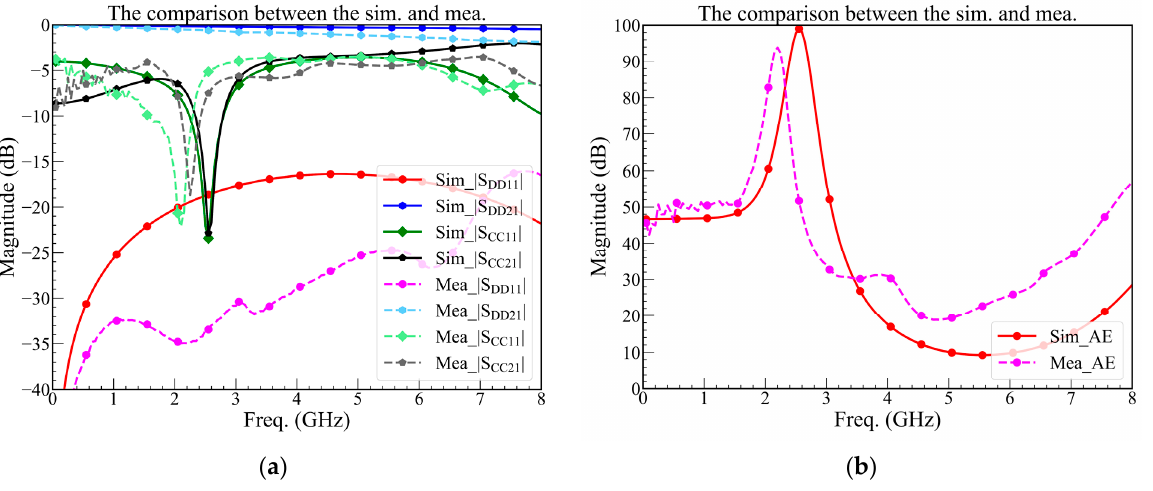
Figure 11. ( a ) The comparison of mixed-mode S -parameter of simulation and measurement; ( b ) the comparison of absorption efficiency of simulation and measurement.